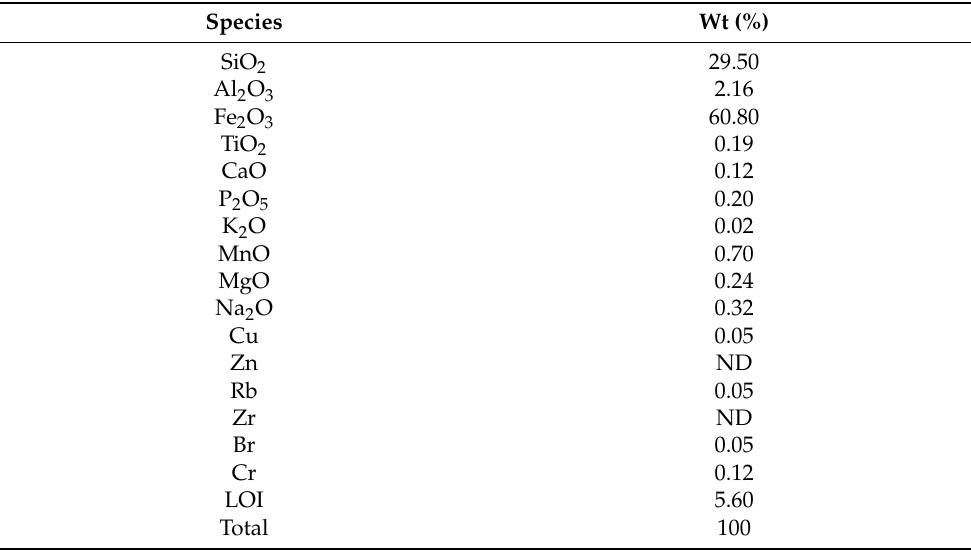
Table 1. X-ray fluorescence spectrophotometry of iron oxide nanoparticles.